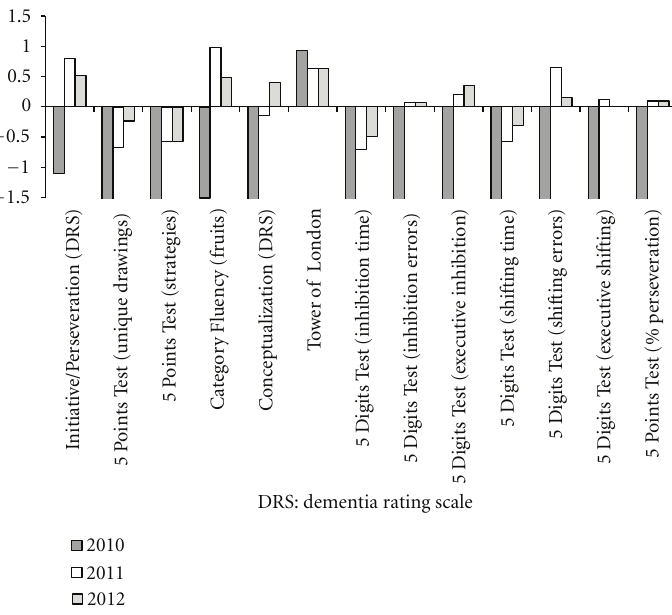
Figure 1: Executive functions